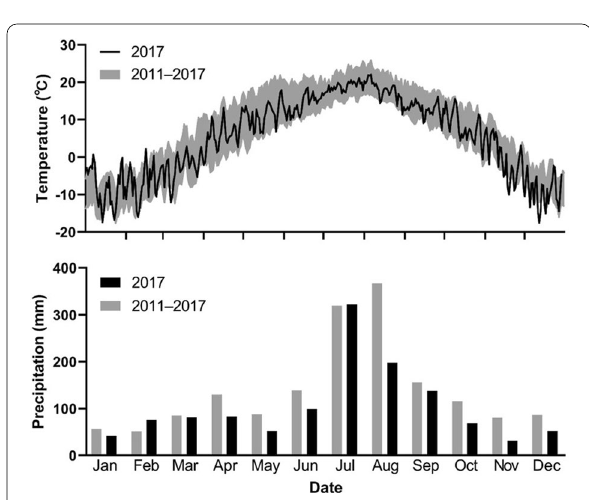
Fig. 2 Daily mean temperature in 2017 (black line) with the mean temperature ranging between maximum and minimum for the last 7 years (2011–2017) (grey background), and comparisons of monthly precipitation in 2017 (black bar) with mean monthly precipitation for the last 7 years (2011–2017) (grey